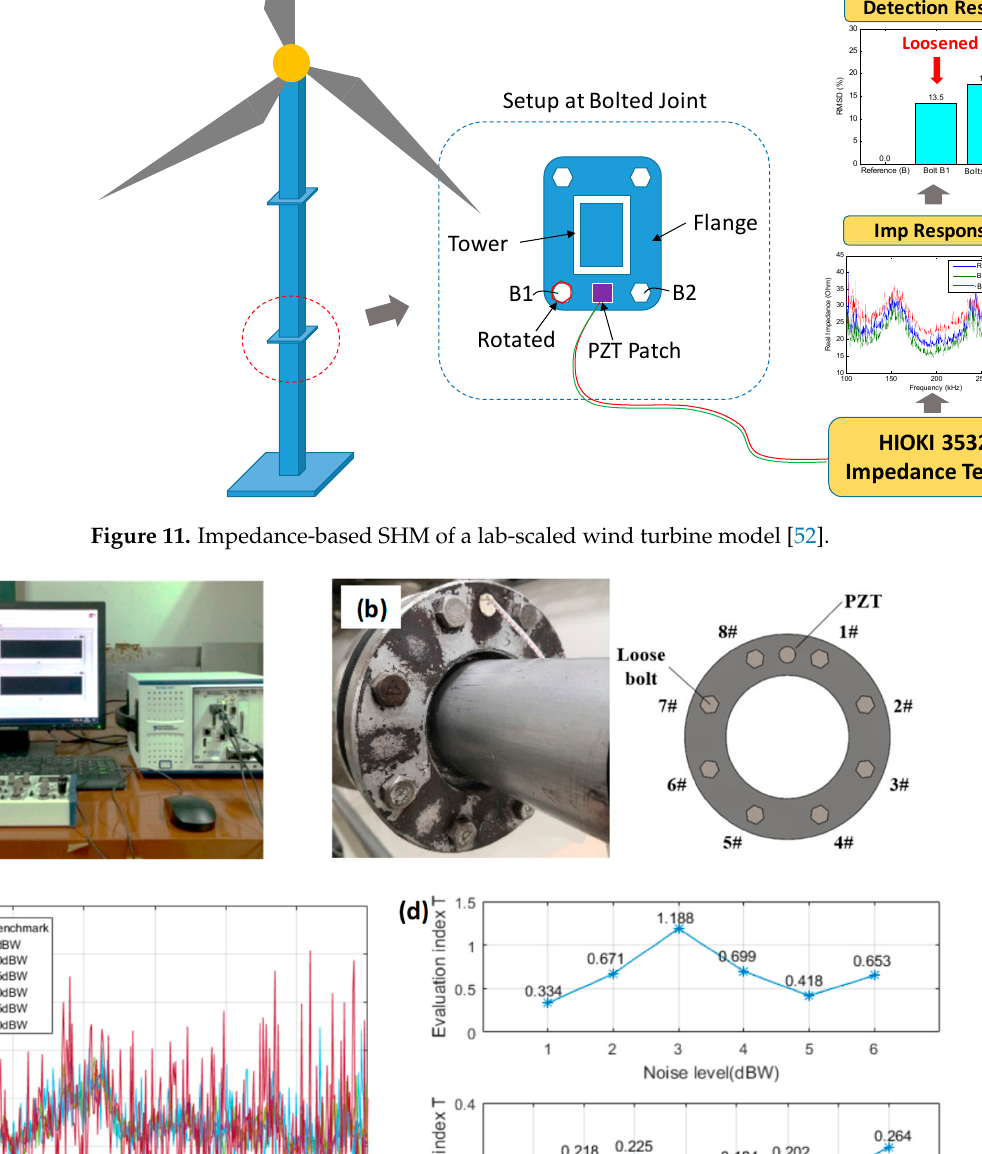
Figure 13. Impedance-based SHM of a valve using wearable technique: ( a ) wearable sensor device, ( b ) layout of the device, ( c ) device mounted on a valve, and ( d ) loosening index vs. bolt torque (adapted from [103] ). 4.2.2. Monitoring of Tower Segment